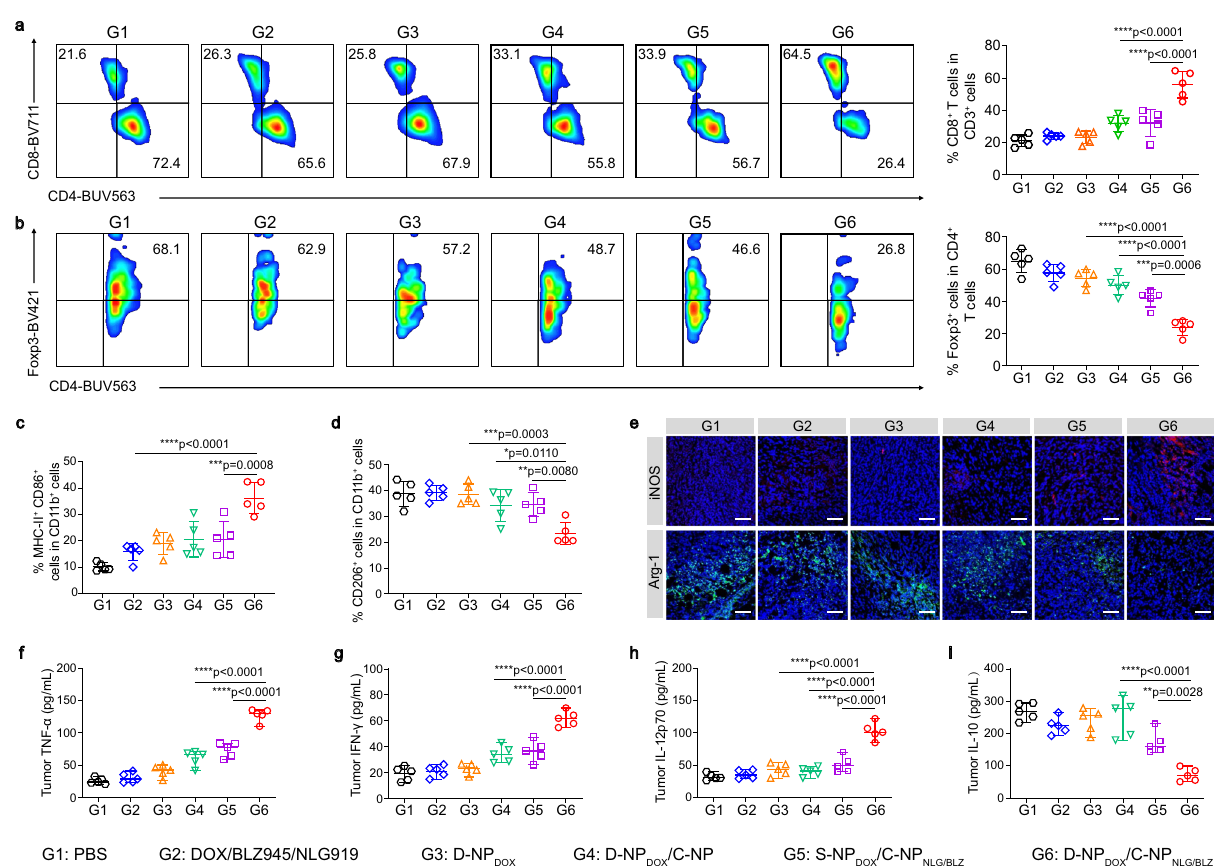
Fig. 7 D-NP/C-NP-mediated cocktail chemoimmunotherapy relieves the immunosuppressive tumor microenvironment. a Representative fl ow cytometry images (left) and relative quanti fi cation (right) of CD8 + cells. Data are presented as the mean ± s.d. ( n = 5). b Representative fl ow cytometric analysis (left) and relative quanti fi cation (right) of Foxp3 + T reg cells. Data are presented as the mean ± s.d. ( n = 5). c , d Relative quanti fi cation of c MHC II + CD86 + M1-like macrophages and d CD206 + M2-like macrophages in F4/80 + CD11b + macrophages. Data are presented as the mean ± s.d. ( n = 5). e Representative immuno fl uorescence staining images for iNOS and Arg-1 in tumor sections. Scale bar, 100 µ m. Experiments were repeated twice. f – i Levels of secreted f TNF- α , g IFN- γ , h IL-12p70 and i IL-10 in tumor tissue. Data are presented as the mean ± s.d. ( n = 5). Statistical signi fi cance